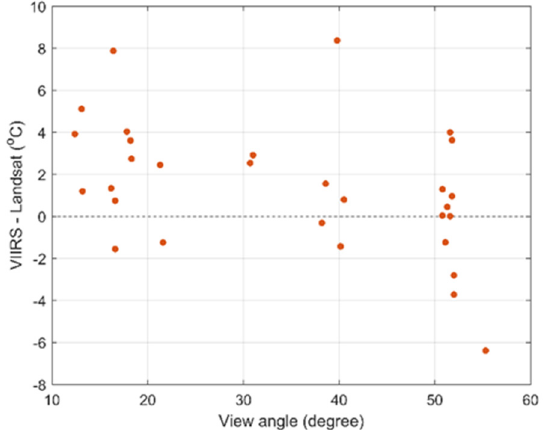
Figure 14. Difference in mean LST between VIIRS and Landsat over the 400 × 400 pixel area as a function of view angle on common overpass days over all the domains.